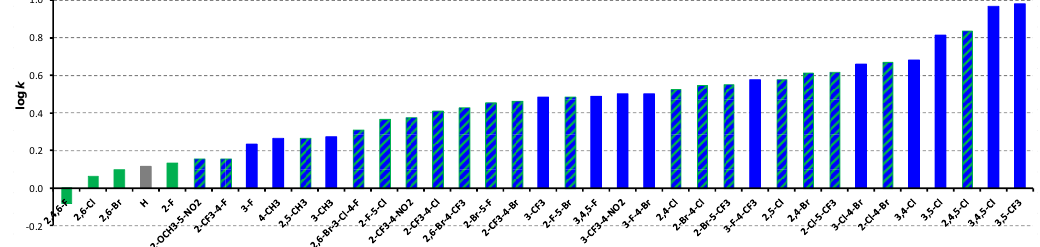
Figure 1. Comparison of experimentally found log k values of ring-substituted N -arylcinnamanilides 1 – 37 with log P calculated using ACD/Percepta ( A ) and Clog P calculated using ChemBio DrawUltra ( B ). Table 1. Structures of ring-substituted (2 E )- N -aryl-3-phenylprop-2-enamides 1 – 37 , experimentally determined values of lipophilicity log k , calculated values of log P /Clog P , electronic σ parameters, in vitro antiplasmodial activity (IC 50 [µM] ± SD, n = 3) compared to chloroquine (CQ), and in vitro antitubercular activity (MIC [µM]) in comparison with isoniazid (INH).